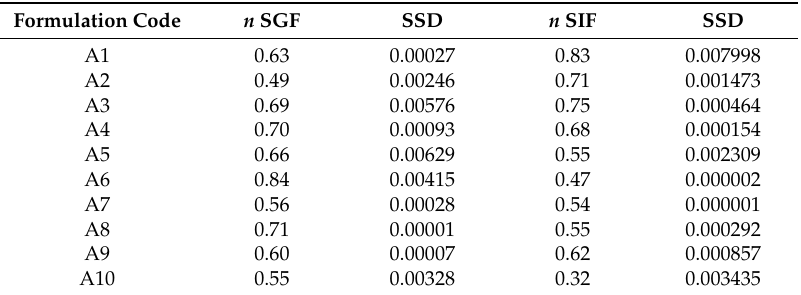
Table 3. Parameter estimation derived from the fitting of experimental data to Peppas-Korsmeyer equation using solver tool from Excel.